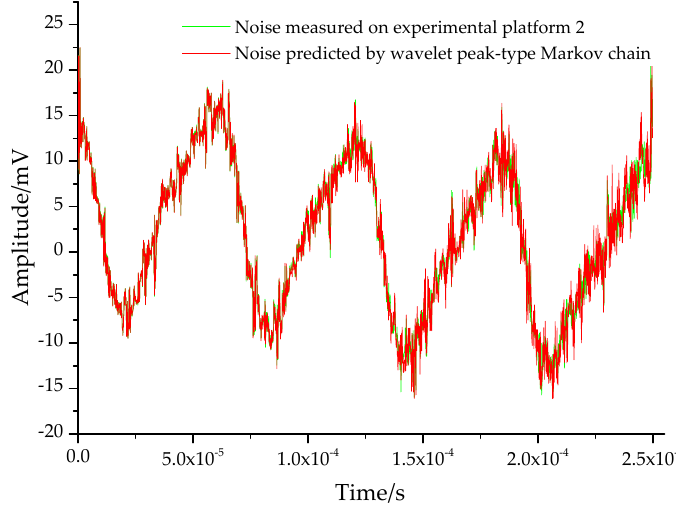
Figure 15. The time-domain waveforms of measured noise before and after modeling. Energies 2019 , 12 , x FOR PEER REVIEW